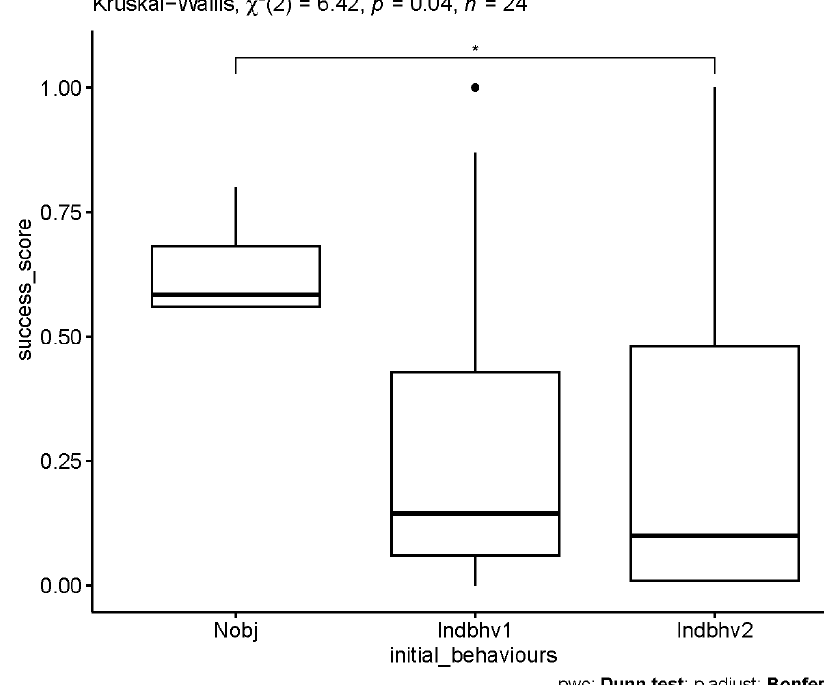
Figure 4. Effect of initial state interactions on transitions in behavioural state of the behavioural chain, based on differences in transition probabilities (pij(Nobj) − pij(Indbhv1) − pij(Indbhv2). The star symbol indicates the statistically significant values, the dot symbol indicates the